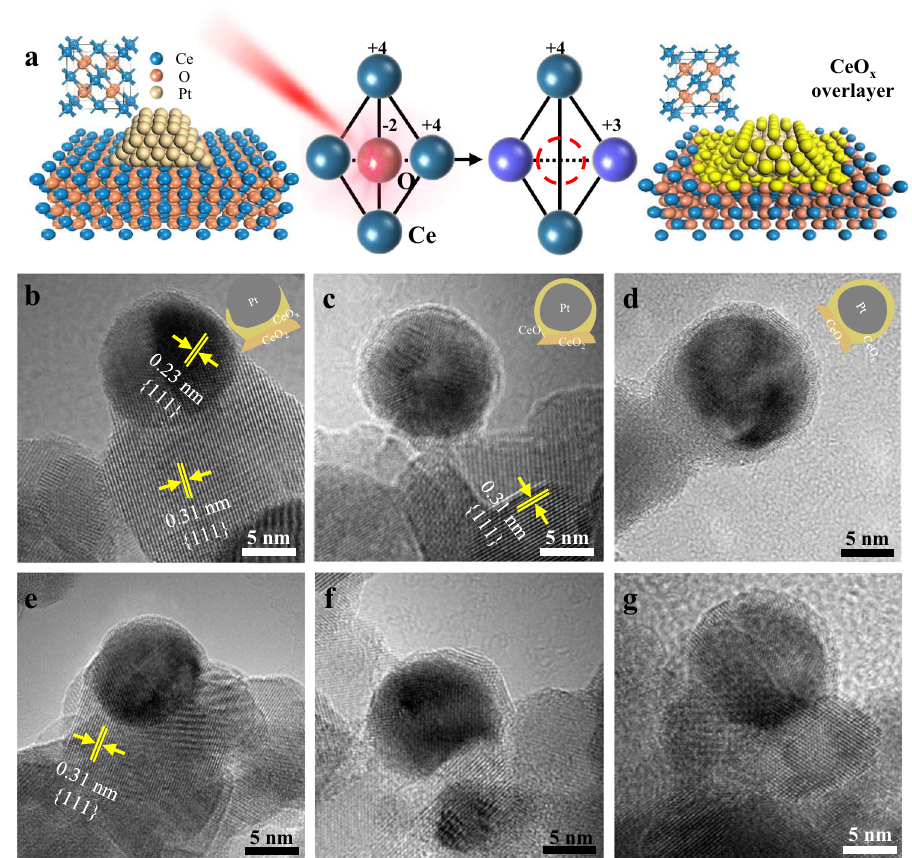
Fig. 4 Mechanisms of the ultrafast laser-induced SMSI. a Explanation of ultrafast laser-induced formation of CeO x overlayer. TEM images of Pt/CeO 2 after ultrafast laser irradiation with various exposure time of ( b ) 20 min, c 40 min, d 60 min (laser power: 250 mW), and laser power of ( e ) 80 mW, f 160 mW, g 250 mW (exposure time: 60 min). Insets are schematics of laser-fabricated Pt/CeO 2